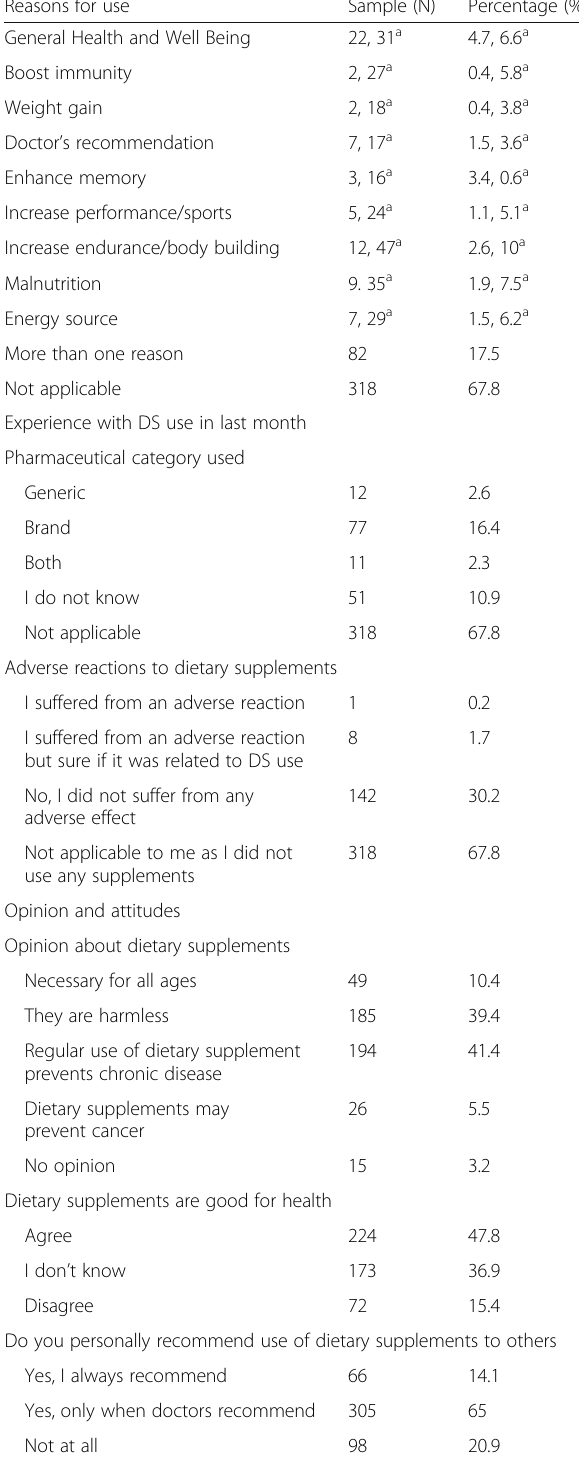
Table 4 Reasons for use, experience with DS, opinions and attitudes towards dietary